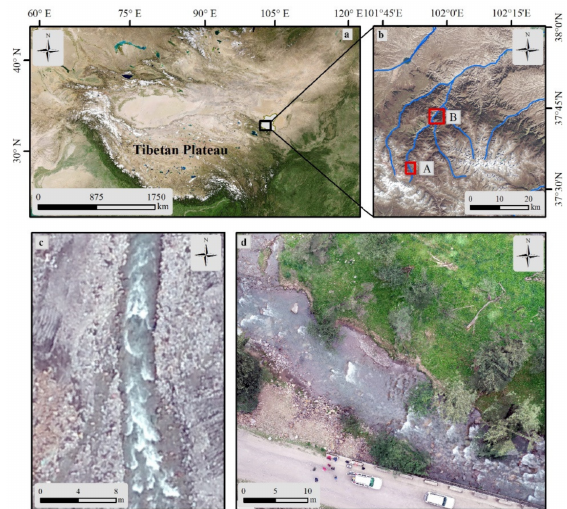
Figure 1. ( a ) Location of the Shiyang River in the Qilian Mountains; ( b ) locations of A and B in the Shiyang River basin; ( c ) orthophoto at A; ( d ) orthophoto at